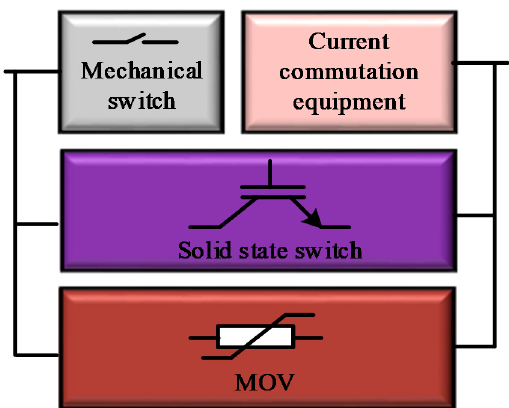
Figure 4. Requirements of the solid-state switch in hybrid circuit breaker.